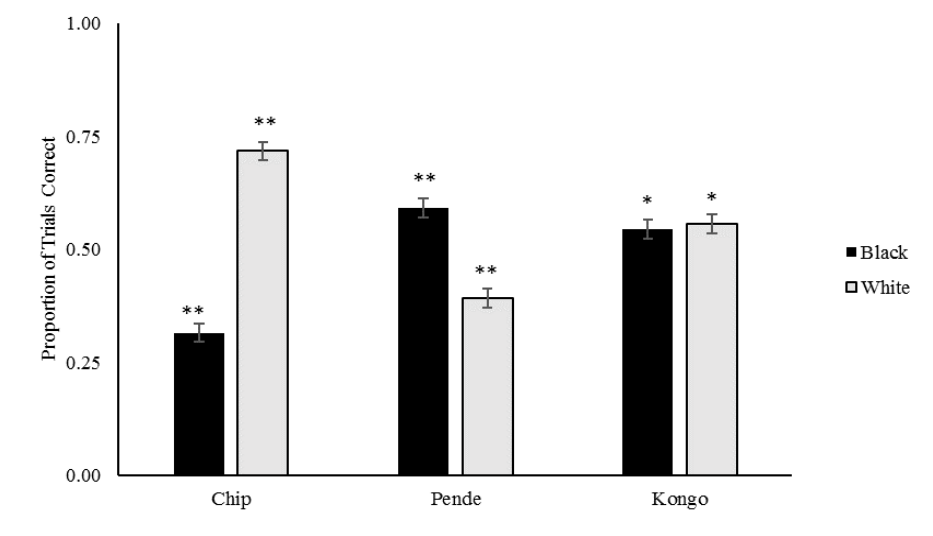
Figure 3. Proportion of correct trials for the last 100 sessions across background colors for each gorilla (* p < .05, ** p <